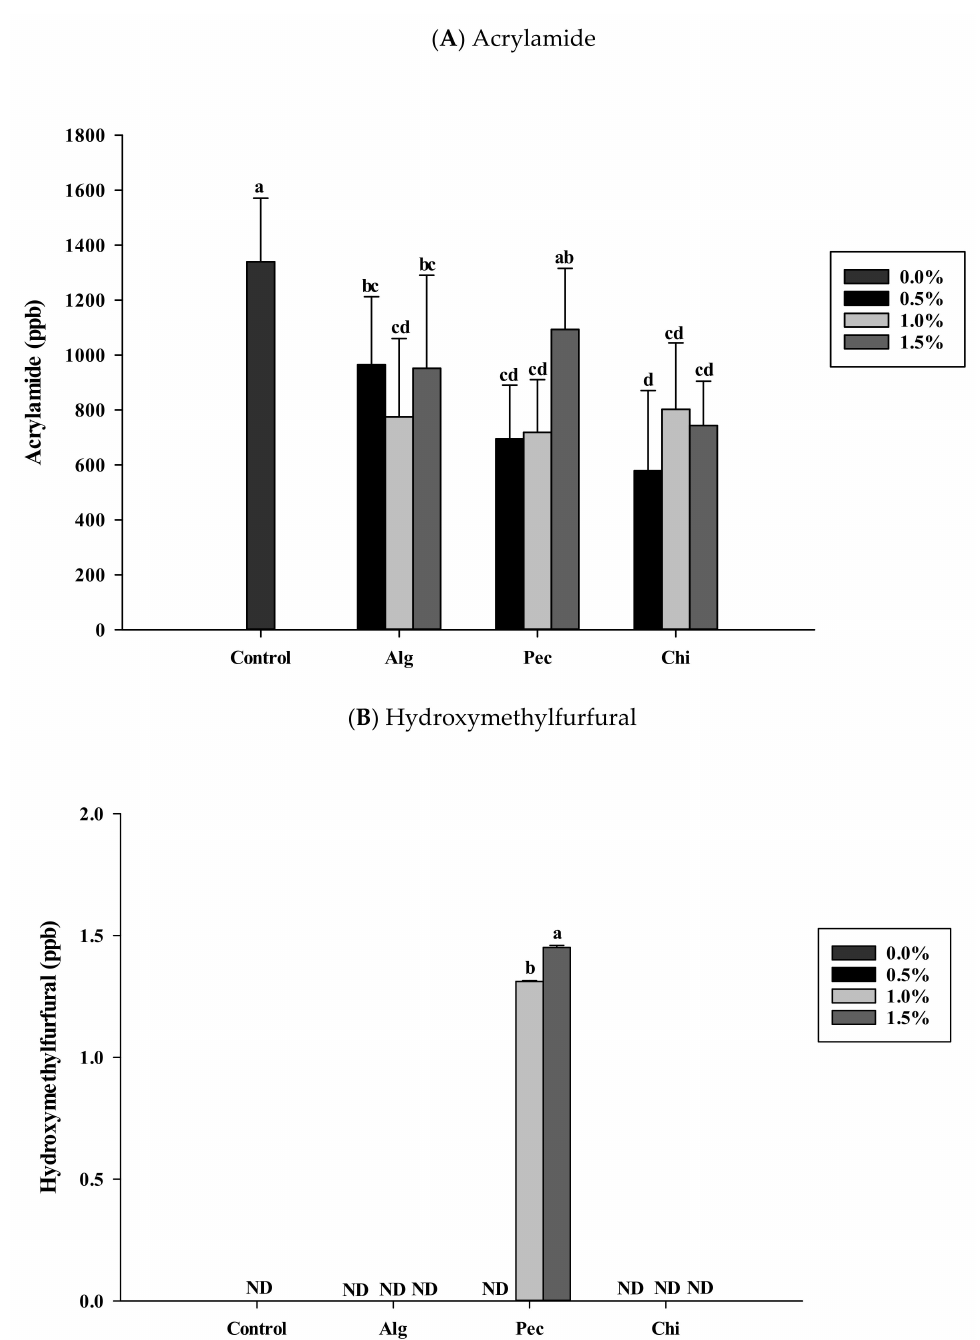
Figure 2. Acrylamide ( A ) and HMF ( B ) contents of biscuits added of sodium alginate, pectin and chitosan in different concentrations. a, b, c, d: indicate statistically significant difference ( p < 0.05) among treatments ( n = 3). Alg: Sodium alginate; Pec: Pectin; Chi: Chitosan; ND: Not